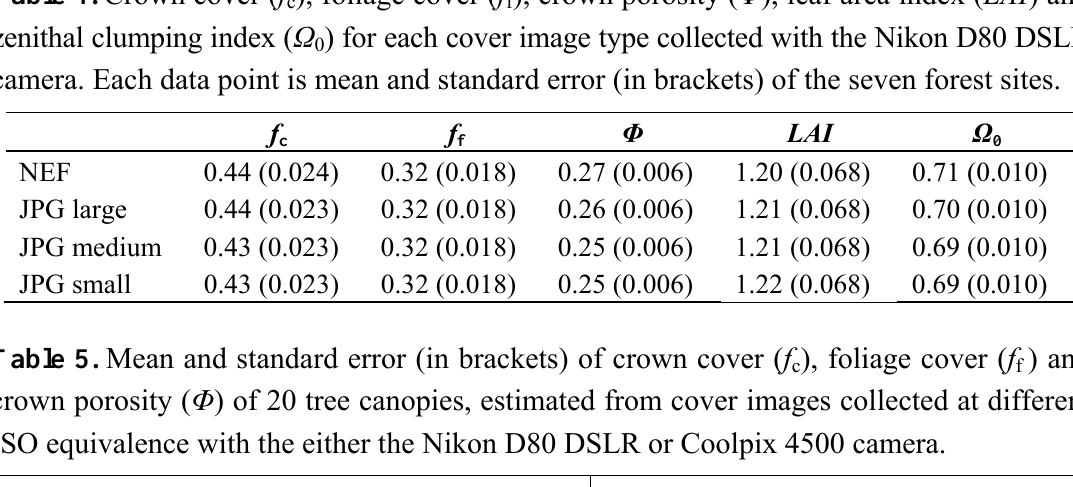
Table 4. Crown cover ( f ), foliage cover ( f ), crown porosity ( Φ ), leaf area index ( LAI ) and c f ) for each cover image type collected with the Nikon D80 DSLR zenithal clumping index ( Ω 0 camera. Each data point is mean and standard error (in brackets) of the seven forest sites.